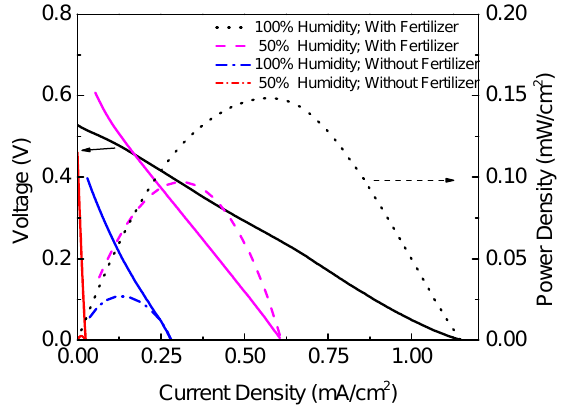
Figure 9. Fertilizer PMFC